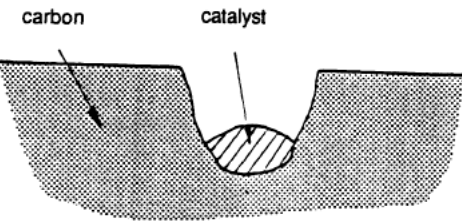
Figure 5. Pitting of a graphite basaf plane.